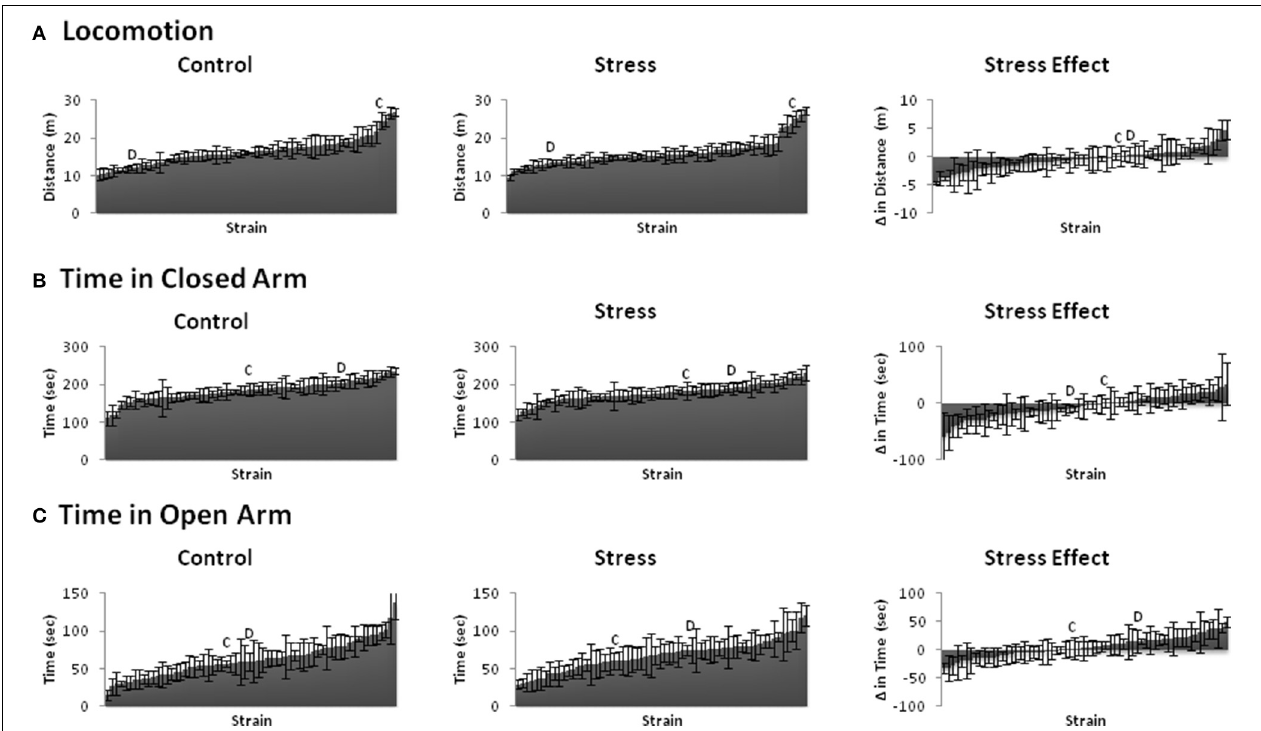
FIGURE 3 | Behavioral phenotypes of the elevated plus maze. Mean ± s.e.m.distanceortimespentforControl(Left)andStress(Middle)populations, and mean ± s.e.m. difference in distance or time spent between littermates